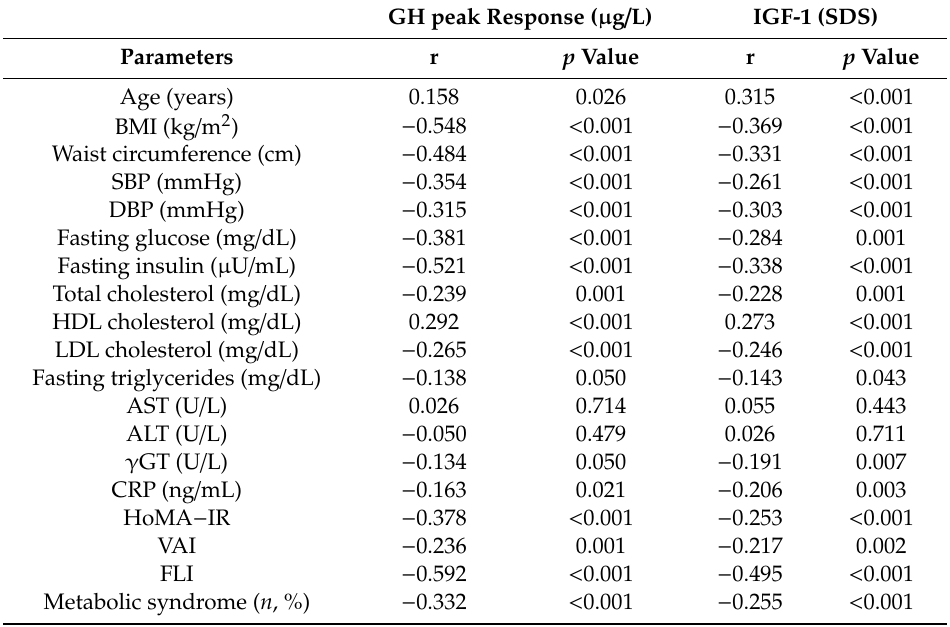
Table5. CorrelationbetweenGHpeakresponseandIGF-1SDSwithSocio-demographic, anthropometric measures and metabolic profile.